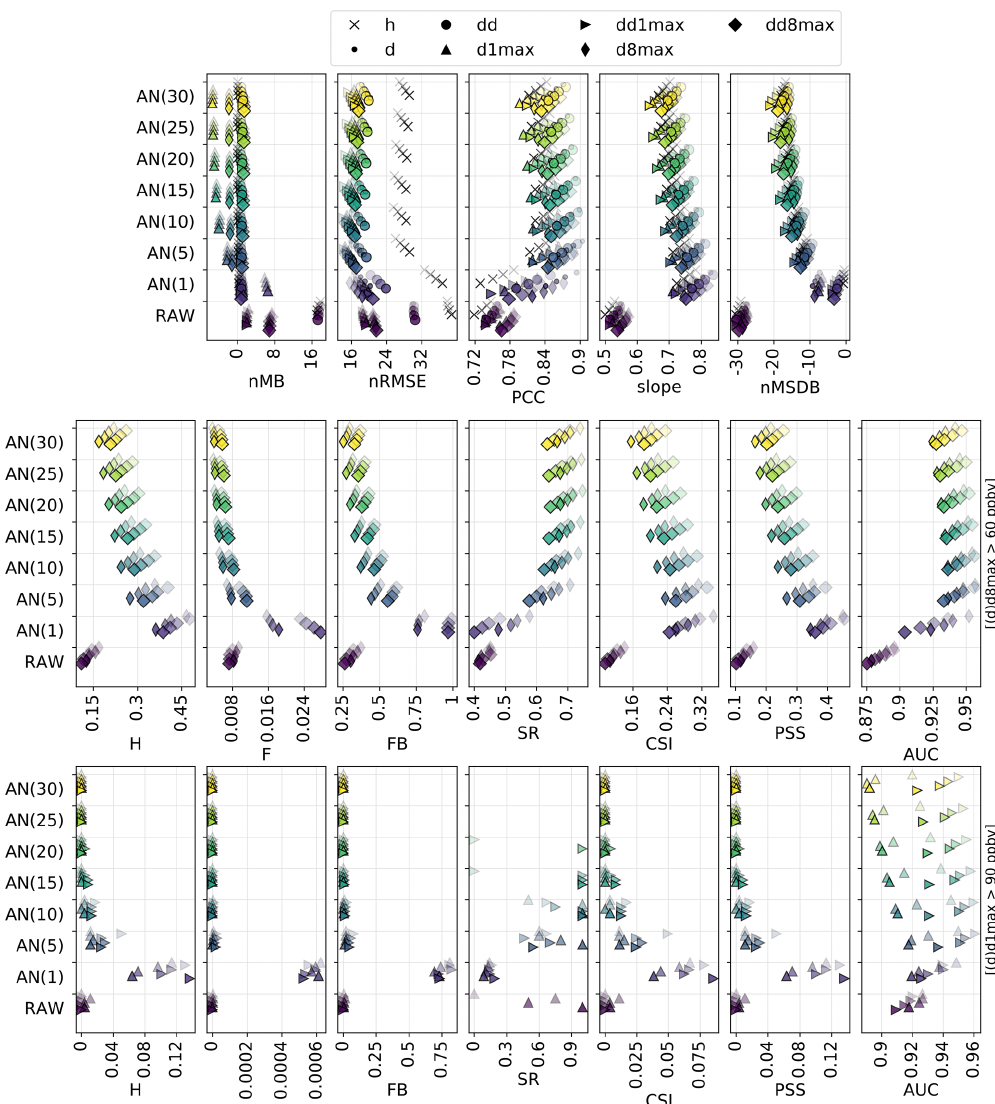
Figure G4. Similar to Fig. 3 for sensitivity tests on the AN method.